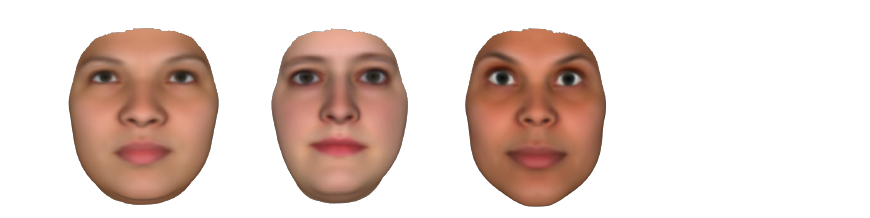
Figure 5. Synthetically generated FaceGen faces rendered with the Preview composite statistical appearance models (SAM).